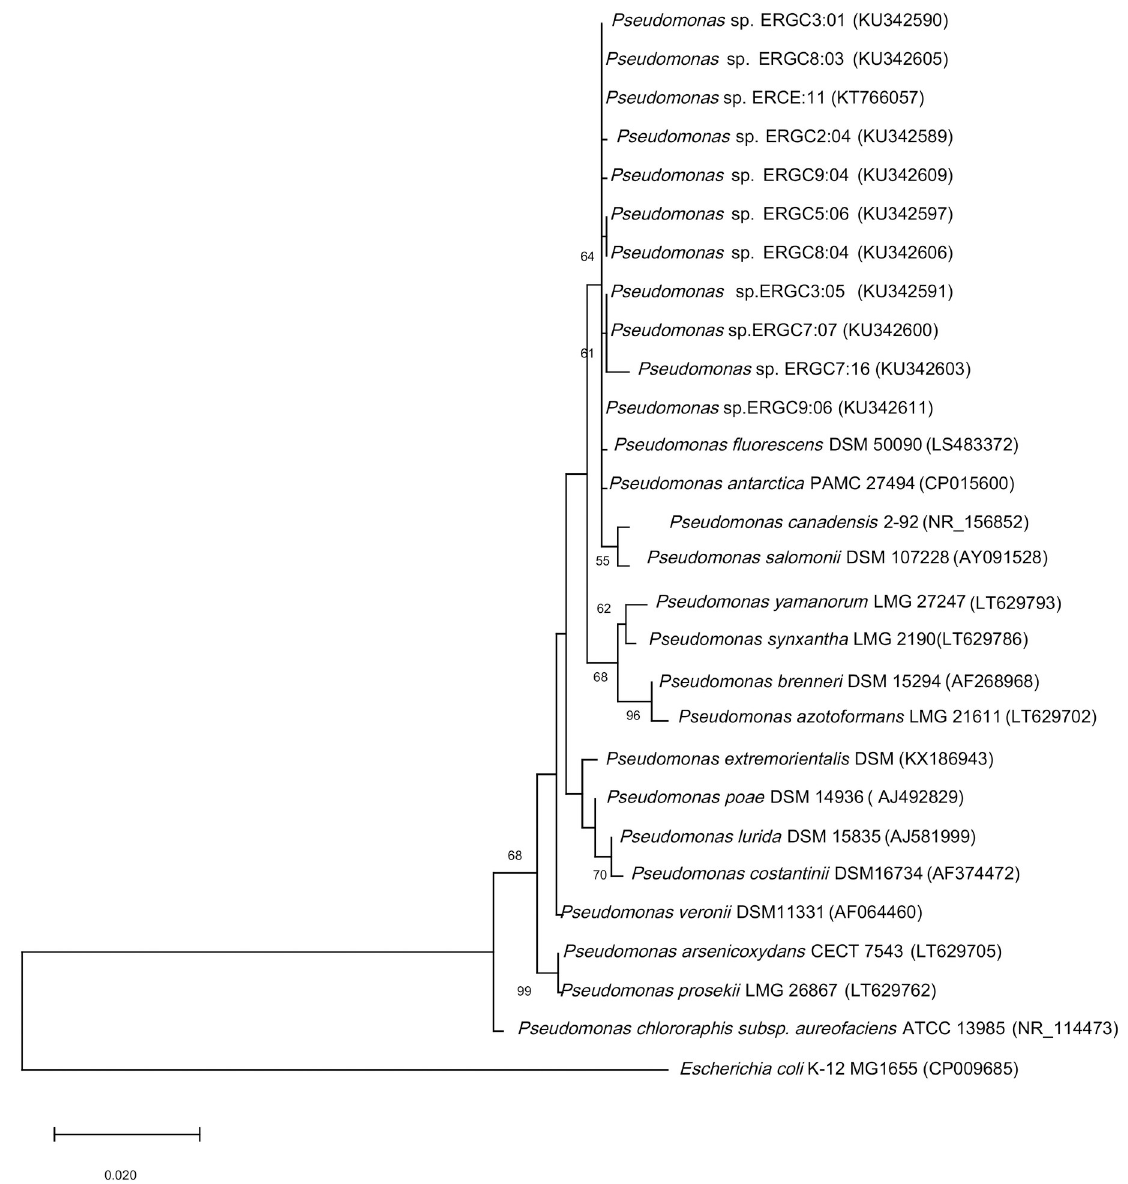
Fig 2. Maximum likelihood tree based on the partial 16S rRNA gene sequences of the 11 Pseudomonas strains and closely related validly published strains of the Pseudomonas genus obtained from NCBI database. The 11 Pseudomonas strains show clustering with both P . fluorescens and P . antarctica . E . coli K12 MG1655 was used as the outgroup organism. The tree was constructed using MEGA X software based on the Kimura 2-parameter model with 1000 bootstrap replications, and the scale bar corresponds to the average number of nucleotide substitutions per site. Accession numbers are given in